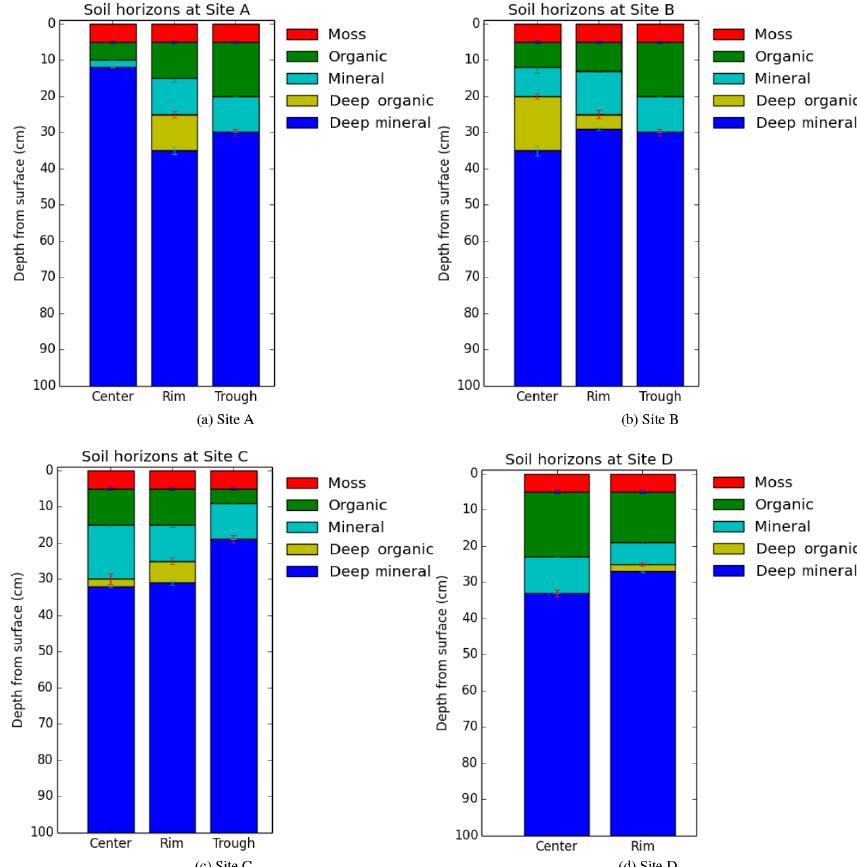
Figure 3. Subsurface soil horizons across microtopographic positions at Sites A, B, C and D based on field observations. Models at study sites were parameterized using these